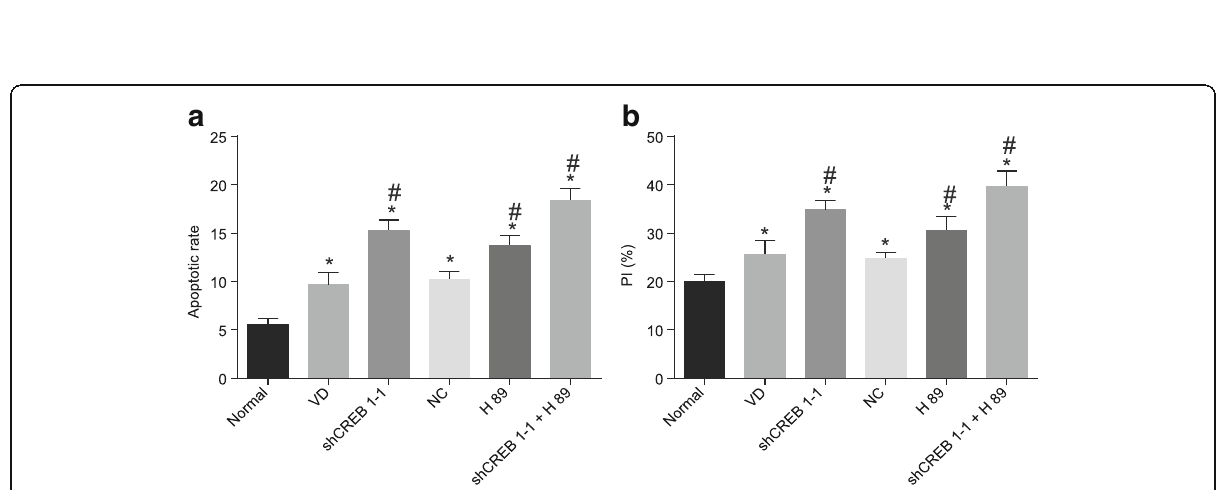
Fig. 5 Increased PI and rate of apoptosis of hippocampal cells in mice injected with shCREB1 – 1 or/and H89, Notes: A, the apoptotic rate of hippocampal cells of mice in each group; B, the PI of hippocampal cells of mice in each group; * , p <0.05, compared with the normal group; # , p < 0.05, compared with the VD group; PI, proliferation index; VD, vascular dementia; CREB1, cyclic adenosine monophosphate responsive element-binding protein